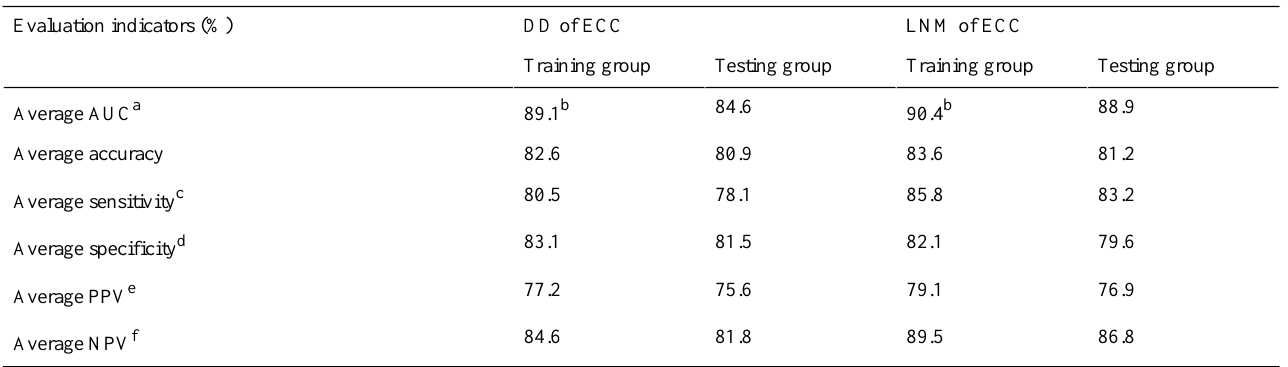
Table 4. The performance of the radiomics prediction model for predicting differentiation degree (DD) and lymph node metastases (LNM) of extrahepatic cholangiocarcinoma (ECC) by using a particle swarm optimization and support vector machine (PSO-SVM)